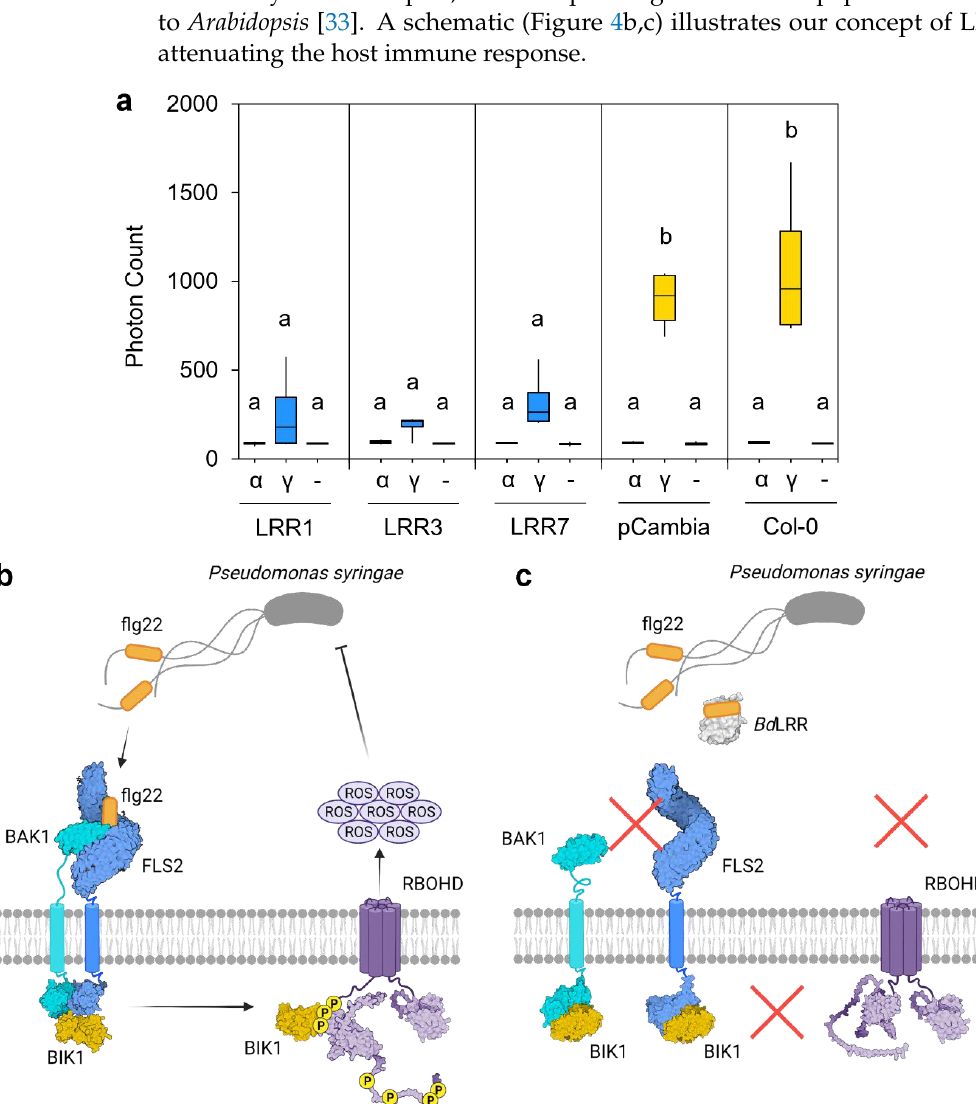
Figure 4. Interaction of Brachpodium leucine-rich repeat (LRR) protein sequences with bacterial fla- gellin protein (flg22.) ( a ) Representative oxidative burst assays (reactive oxygen species) as assessed by the measurement of emitted photons as a proxy for Arabidopsis immune response. Results are shown for untransformed wildtype Arabidopsis (Col-0), Col-0 plants transformed with an empty vector (pCambia1305.1, shown as pCambia), and Arabidopsis lines expressing the BdIRI1, BdIRI3 , and BdIRI7- encoded LRR protein products shown as LRR1, LRR3, and LRR7, respectively. The flg22 epitopes used were the flg22- γ (shown as γ) and flg22 - α (shown as α) peptides previously shown to be immunogenic and non-immunogenic, respectively, to Arabidopsis . Blank controls consisting of no epitope (-) were also included. Lowercase letter groupings represent statistically significant dif- ferences ( p < 0.001, one way ANOVA) and assays were repeated in triplicate with similar results. ( b ) Simplified illustration of how FLAGELLIN-SENSITIVE 2 (FLS2) induces the downstream release of extracellular ROS upon detection of flg22- γ epitopes. ( c ) Simplified illustration of how Bd LRRs may attenuate with the FLS2-dependent release of extracellular ROS in the presence of flg22- γ epitopes. Illustration made using BioRender.com. The AlphaFold LRR1 model showed similarity to the FLS2 crystal structure [34] with opposing beta sheets and irregular alpha-helices forming a concave solenoid-like struc- ture (Figure 5a). To further investigate the potential LRR:flg22 binding suggested by the experimental assays, AlphaFold interactions were modelled as described [35], which